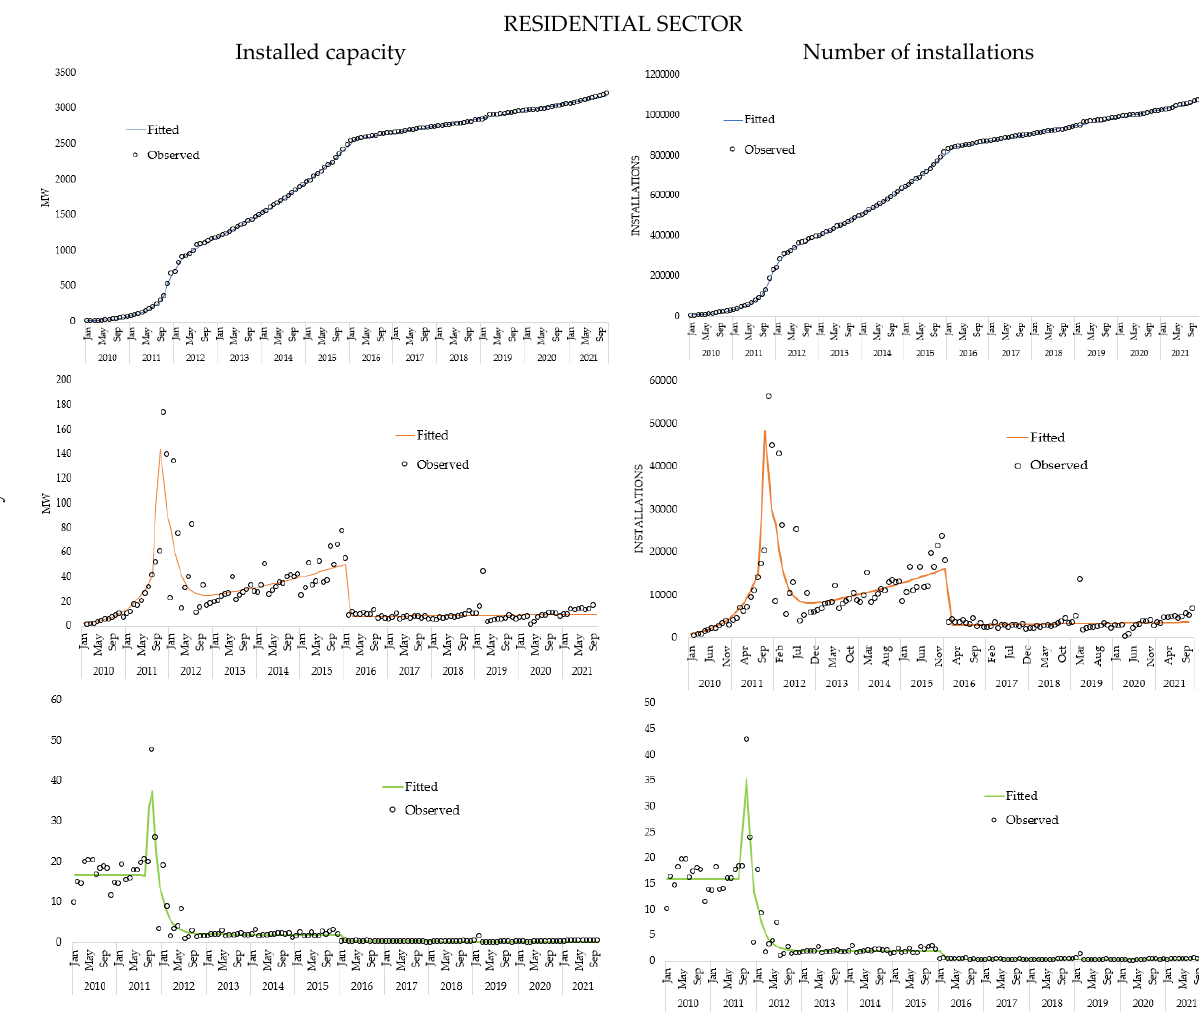
Figure 3. Observed vs. fitted (by the best GIM model) PV adoptions in the UK 2010 – 2021 for the residential sector by installed capacity and by numbers of installations. For each category considered, the figure reports: (i) cumulative adoptions, (ii) monthly adoptions, and (iii) growth rate of cumulative adoptions.